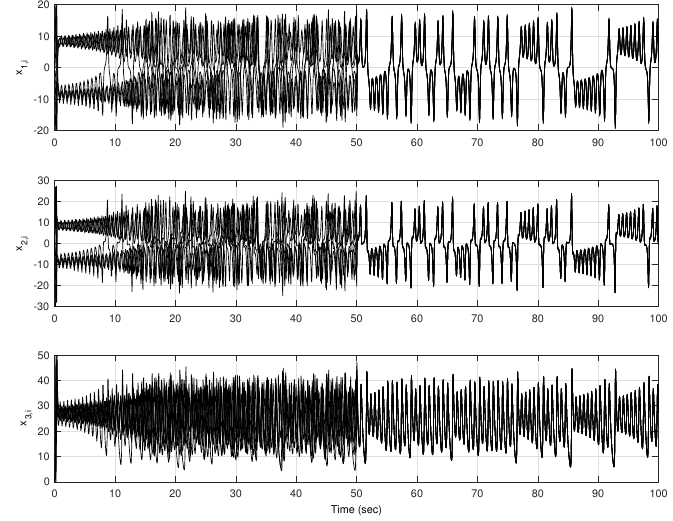
Figure 5. Time evolution of the systems in the nodes connected using chaotic couplings at t = 50